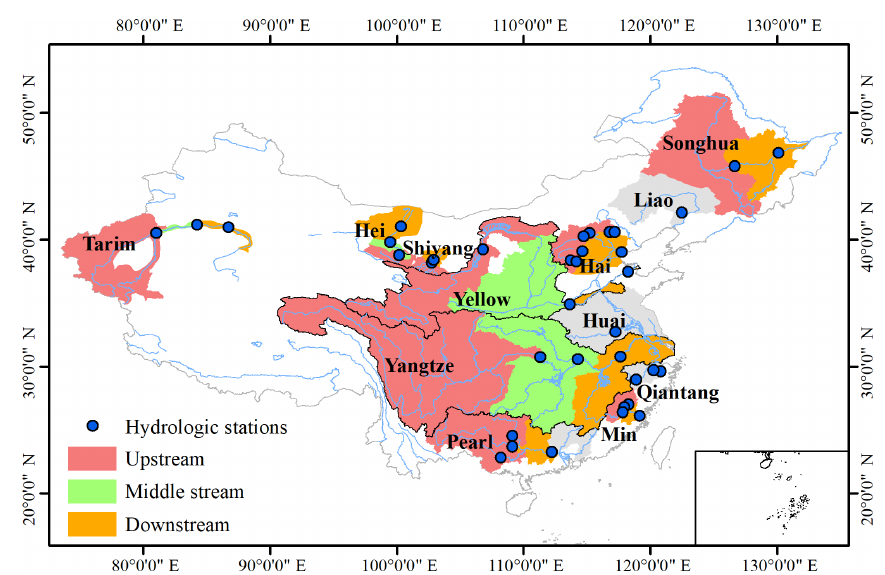
Figure 1. The locations of the 12 basins and 37 hydrologic stations. Upstream, middle stream, and downstream were identified by red, green, and yellow colors,